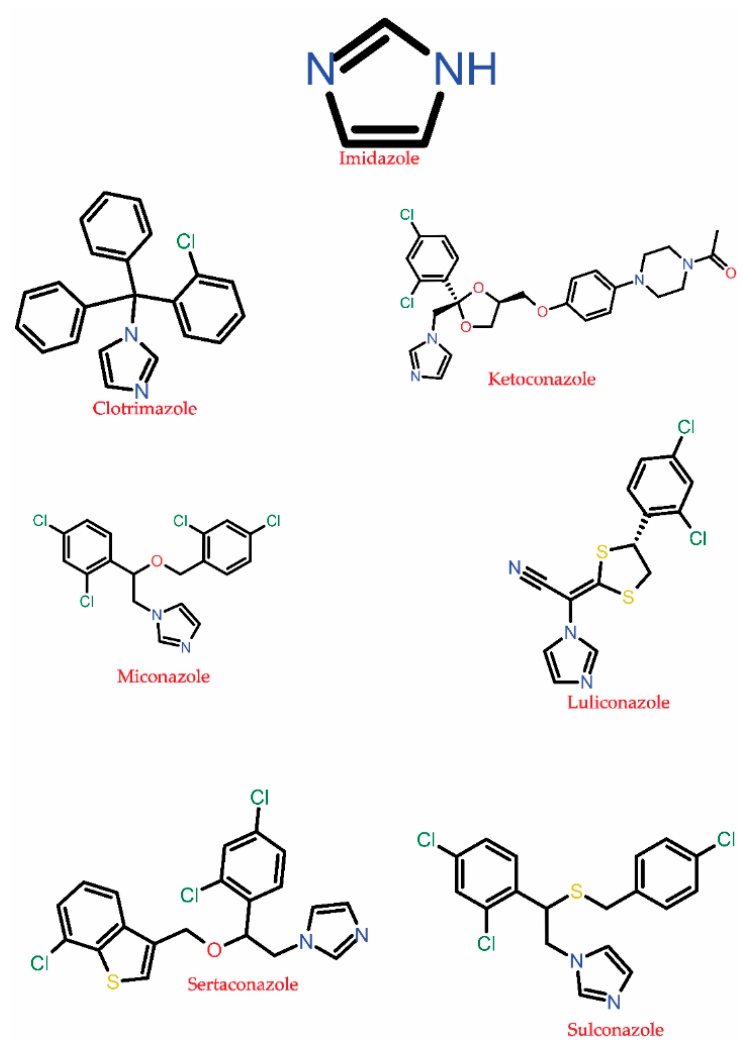
Figure 5. Two-dimensional structure of drugs under the imidazole group.